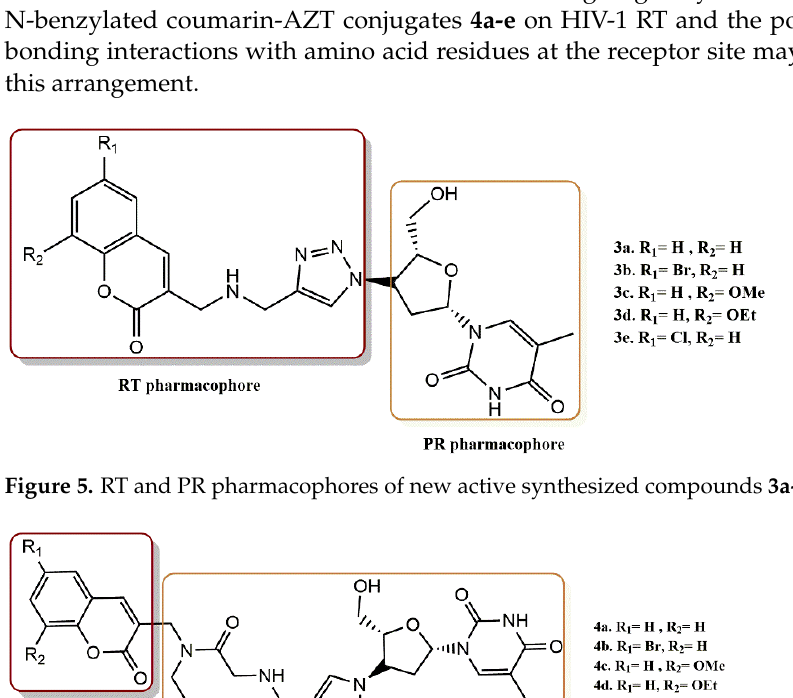
Figure 5. RT and PR pharmacophores of new active synthesized compounds 3 a-e .